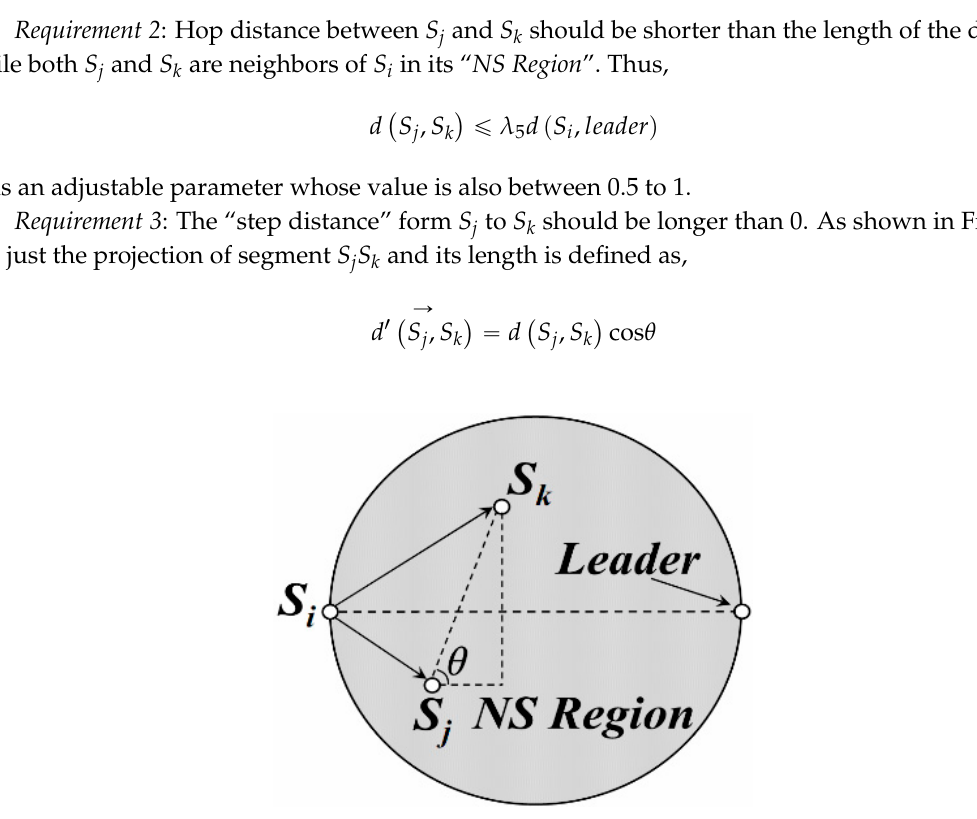
Figure 10. Next-hop node selection in DGA.